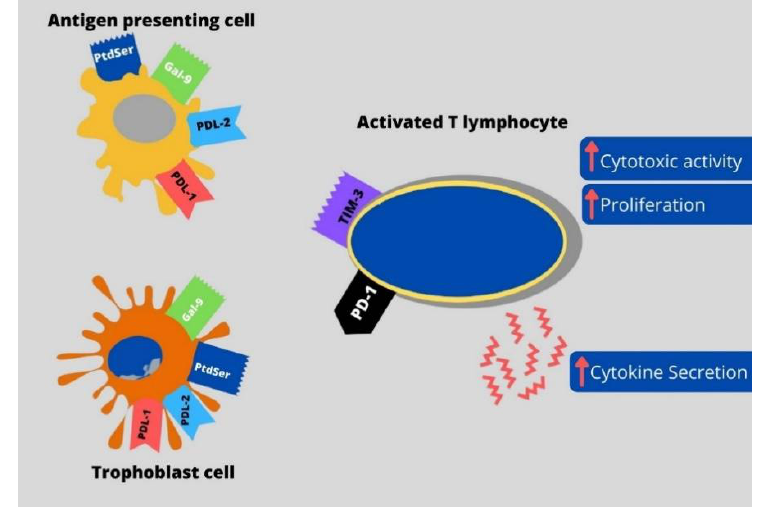
Figure 1. Distribution of immune checkpoints and their ligands on antigen-presenting cells (APCs), trophoblast cells, and activated T lymphocytes: PD-1—programmed cell death protein 1, TIM-3—T cell immunoglobulin-3, PDL1—programmed death-ligand 1, PDL-2—programmed death-ligand 2, PtdSer—phosphatidyl serine, Gal-9—galectin-9.